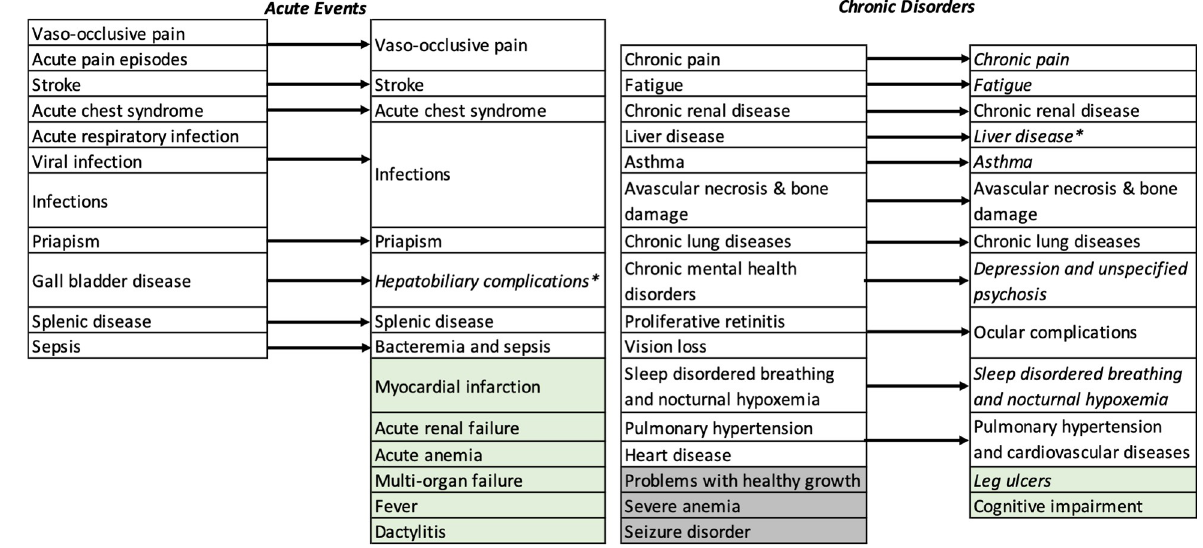
Fig 1. Disease attributes considered for inclusion in the model structure. Arrows indicate the refined categorization following expert consultation. Attributes shown in green were added and attributes shown in grey were removed. Italicized disease attributes were classified as subacute disorders. � Combined following empirical analysis of prevalence in MarketScan commercial claims database and classified as a subacute disorder.